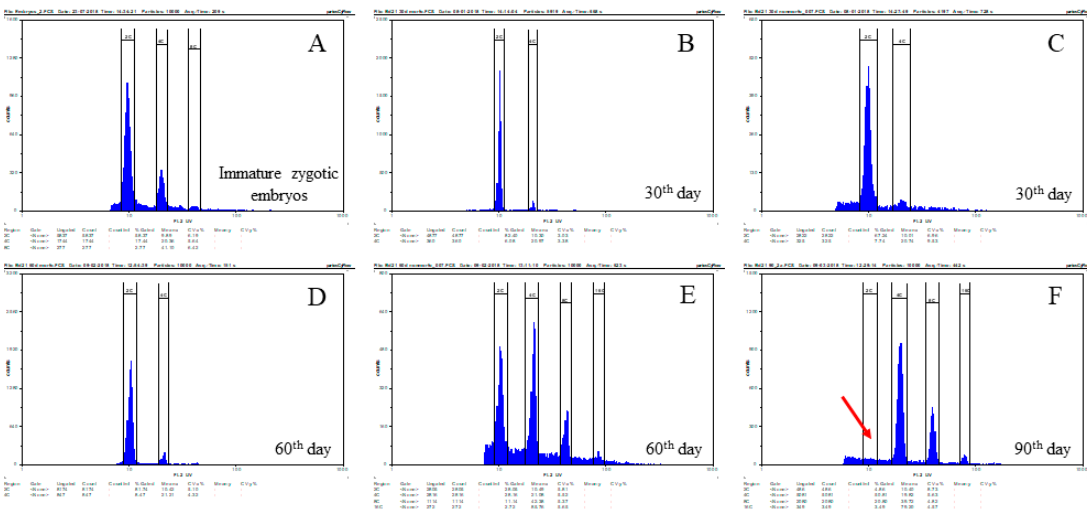
Figure 5. Relative transcript accumulation levels of ( A ) YUC (Bradi5g01327), AIL (Bradi1g72890), SERK (Bradi3g46747 and Bradi5g12227), LEA (Bradi5g26600), BBM (Bradi2g577747 and Bradi4g14960), CLV3 (Bradi1g05010) , and ( B ) WUS (Bradi5g25113) and YUC (Bradi1g72500) genes on the 30th, 60th, and 90th day of cultivation. The relative transcript accumulation levels were normalised to an internal control ( AK437296 , a gene encoding ubiquitin) and calibrated to the control (explants, zygotic embryos); *: value is significantly different from the control (Student’s t -test, p < 0.05; n = 3 ± SD). Ten cell cycle-related genes have mostly similar patterns of transcript accumulation. CYCD3 ( Bradi3g58300 ), CYCA3 ( Bradi1g14820 ), CYCB1 ( Bradi2g52760 ), CDKPK ( Bradi1g54570 ), CDKB2 ( Bradi3g40200 ), WEE ( Bradi3g03112 ), and CYCD4 ( Bradi4g32556 ) transcript levels were the highest in 30-day-old calli (Figure 6). Then, the levels decreased on the 60th and 90th day. Unlike other cell cycle-related transcripts, CDKA ( Bradi3g02270 ) and CDKD ( Bradi2g26510 ) showed their highest levels